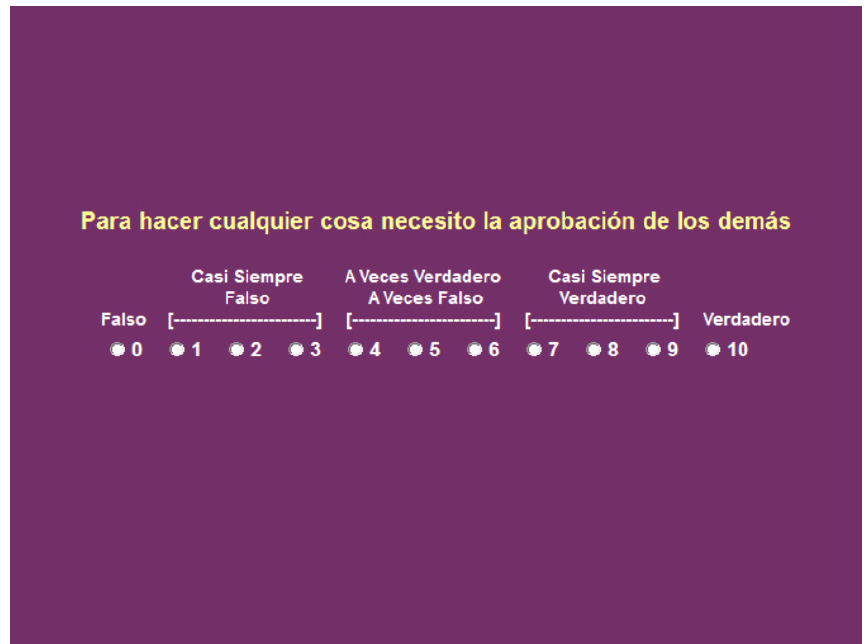
Figure 1. Example of response for the questionnaire items.